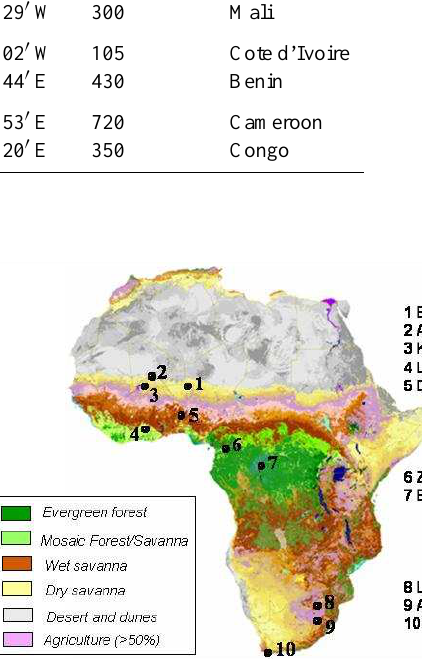
Table 1. Geographic and ecologic characteristics of the Western and Central Africa IDAF sites. Ecosystem Station Latitude Longitude Elevation/m Country Dry savanna